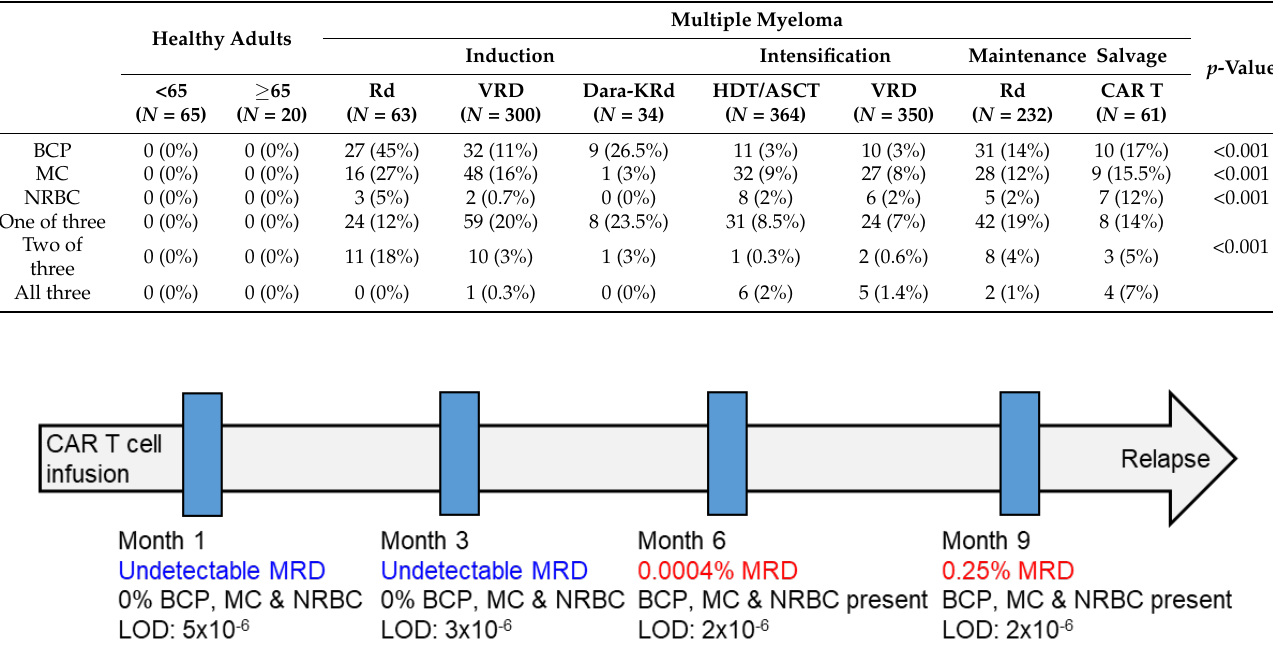
Figure 4. Patient case treated with anti-BCMA CAR T cells. BM aspirates were collected at months 1, 3, 6 and 9 after